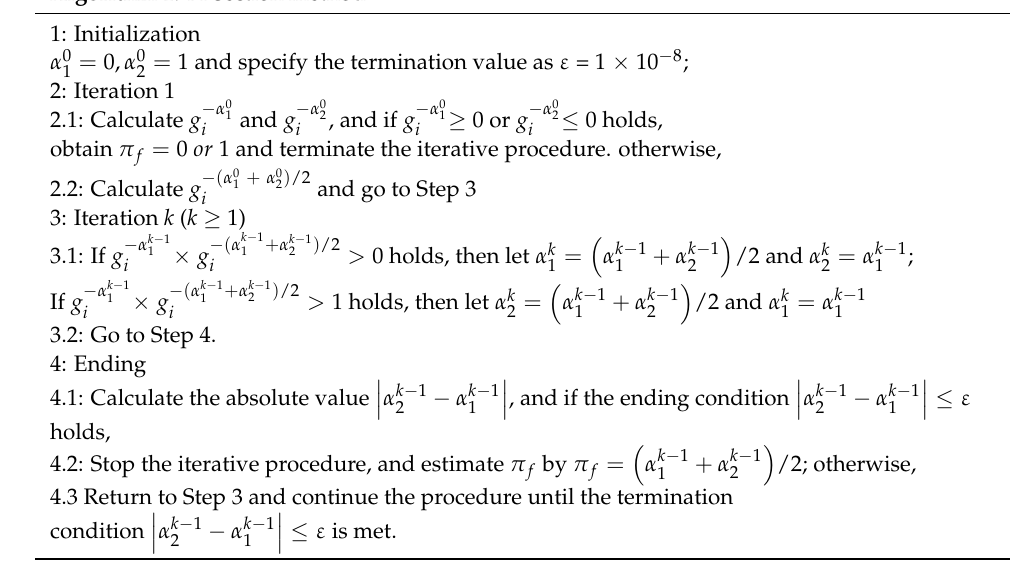
Algorithm 1. Bi-section